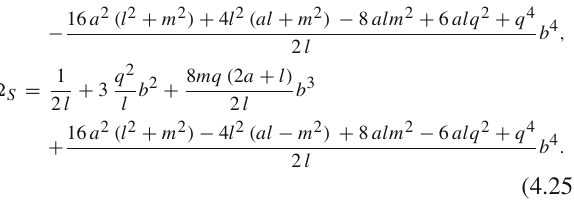
Fig. 15 The electric charge of the black hole as function of q , b (left), and m , l (right), where we set the other black hole parameters to a set of fixed